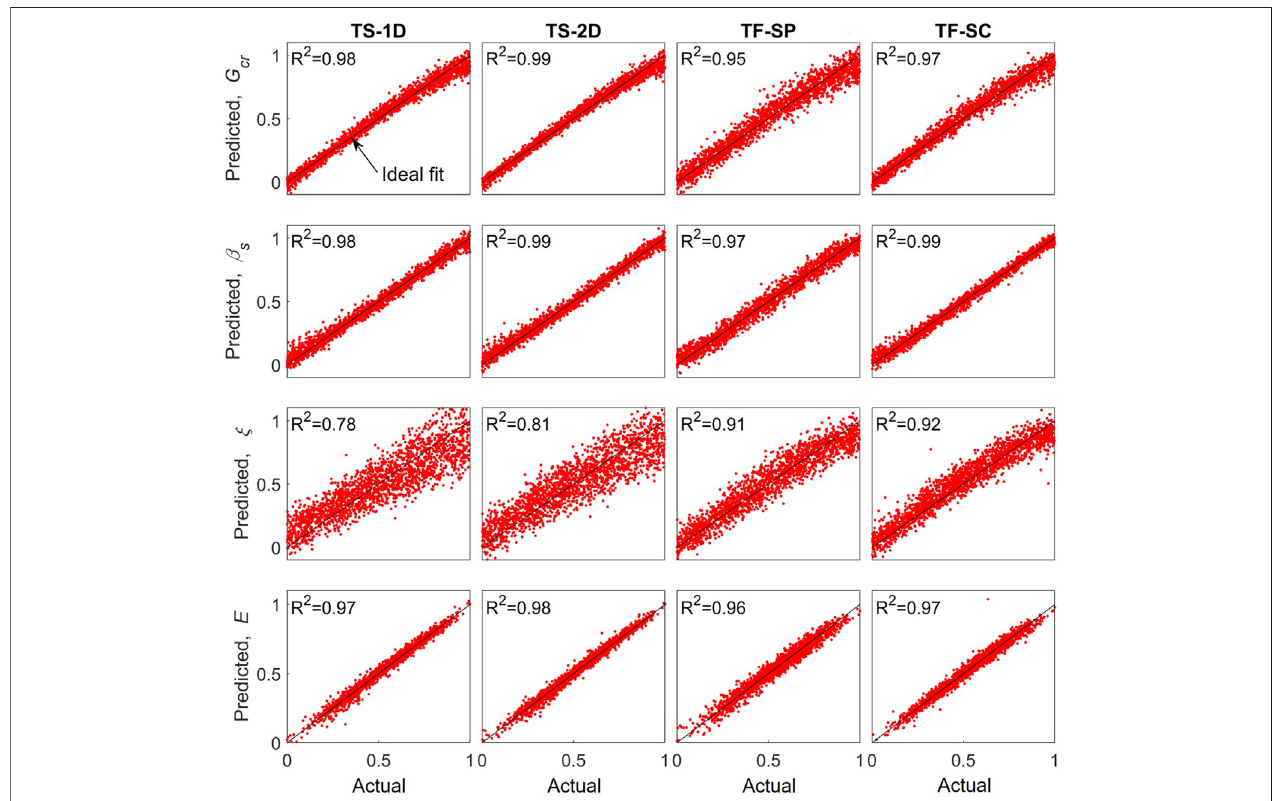
FIGURE 9 | Actual versus predicted post-cracking shear stiffness, G cr , shear deformation unloading coef fi cient, β s , damping ratio, ξ , and cumulative energy dissipation, E, for each representation method.